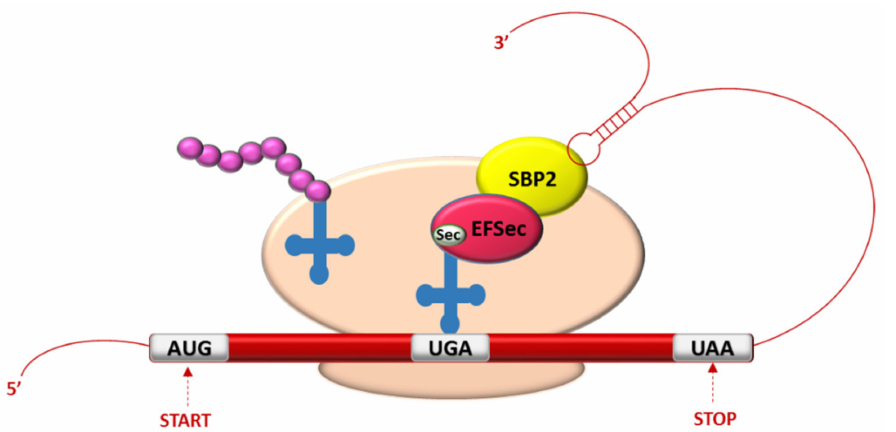
Figure 1. Schematic representation of selenocysteine (SeCys) insertion and the main involved factors. UGA is the SeCys-specific codon. SECIS binding protein 2 (SBP2) is associated to ribosomes and binds the SECIS element. SeCys-specific translation elongation factor (eEFSeCys) interacts with SeCys-tRNA and allows the incorporation of SeCys in the elongating